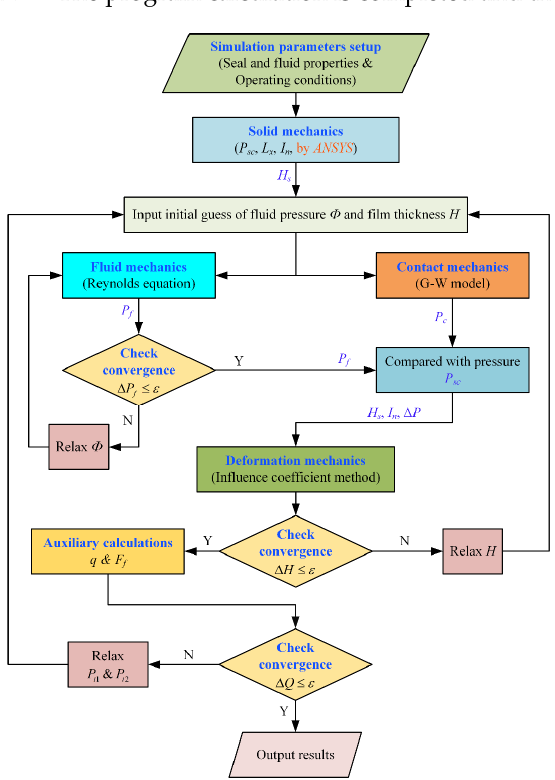
Figure 3. Computational procedure of fluid–structure coupling numerical